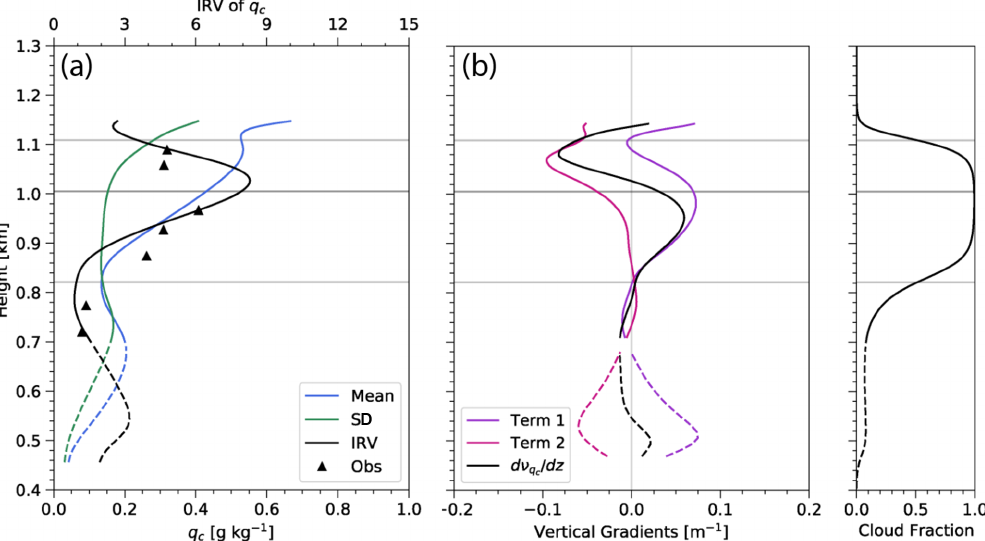
Figure 7. Vertical profiles of the horizontally averaged (a) mean, standard deviation, and inverse variance of q c and (b) the derivatives of the inverse variance of q c . The dashed lines represent the cumulus cloud layer. Triangle markers represent the inverse variance of observed q c . Term 1 and Term 2 are calculated as defined in Eq. (3). The gray lines are as in Fig. 3.